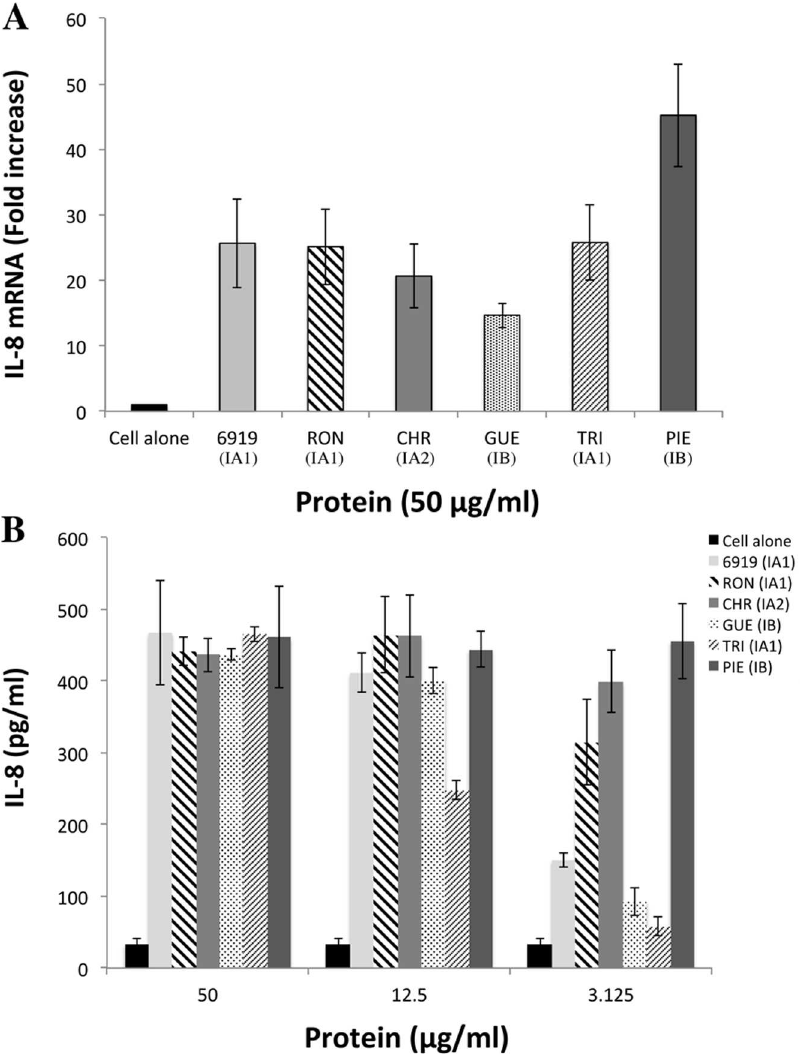
Fig 2. Induction of CXCL8 production in keratinocytes by P . acnes surfaceproteins. HaCaT cells were incubatedfor 18 h with lithium extracts of bacterialproteins at concentrations of 50 μ g/ml (A) and 3.12, 12.5, and 50 μ g/ml (B). Total RNA was extracted and CXCL8 mRNA levels were determined by real-time RT-PCR and comparedwith GAPDH mRNA levels (used as the control), with expressionas a fold-change. CXCL8 production was assessed by ELISA on culture supernatants. Controlexperiments were performed with unstimulated cells. Data are presentedas the mean ± standarddeviationof three independent experiments. Statistical significanceis indicatedby * P (cid:20) 0.05, ** P (cid:20) 0.01, *** P (cid:20) 0.001, **** P (cid:20)